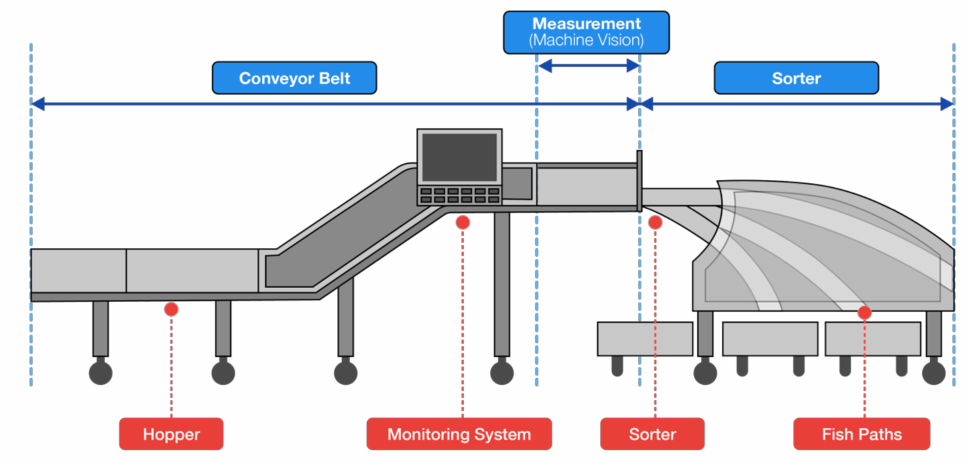
Figure 16. Structure of weight